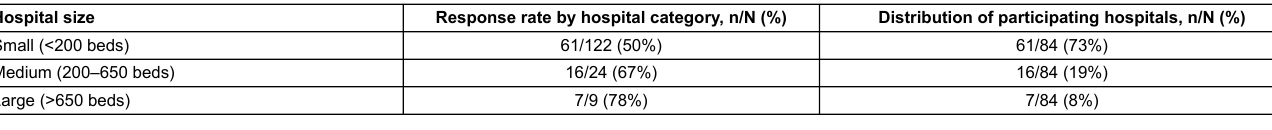
Table 1: Response rate to the Swissnoso surveillance inventory by hospital size. Hospital